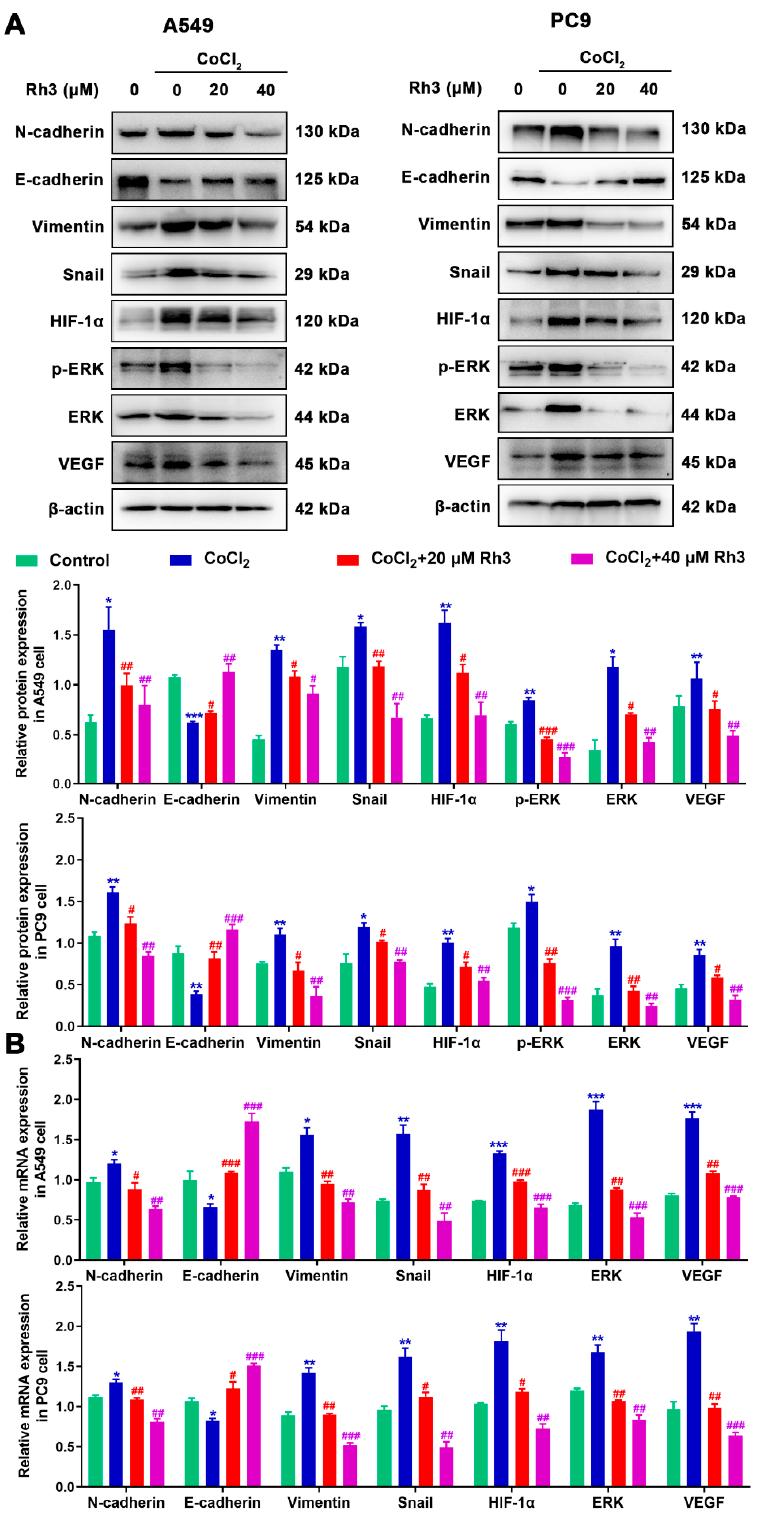
Figure 5. Rh3 (20 and 40 μ M) inhibits EMT progression via the ERK pathway in A549 and PC9 cells. Treatment of the cells with 100 μ M CoCl 2 for 24 h. Western blotting ( A ) and qRT-PCR ( B ) shows the expression levels of N-cadherin, E-cadherin, Vimentin, Snail, HIF-1 α , p-ERK, ERK, and VEGF in A549 and PC9 cells. * p < 0.05, ** p < 0.01, *** p < 0.001 compared with the control; # p < 0.05, ## p < 0.01, ### p < 0.001 compared with control cells treated with CoCl 2 .